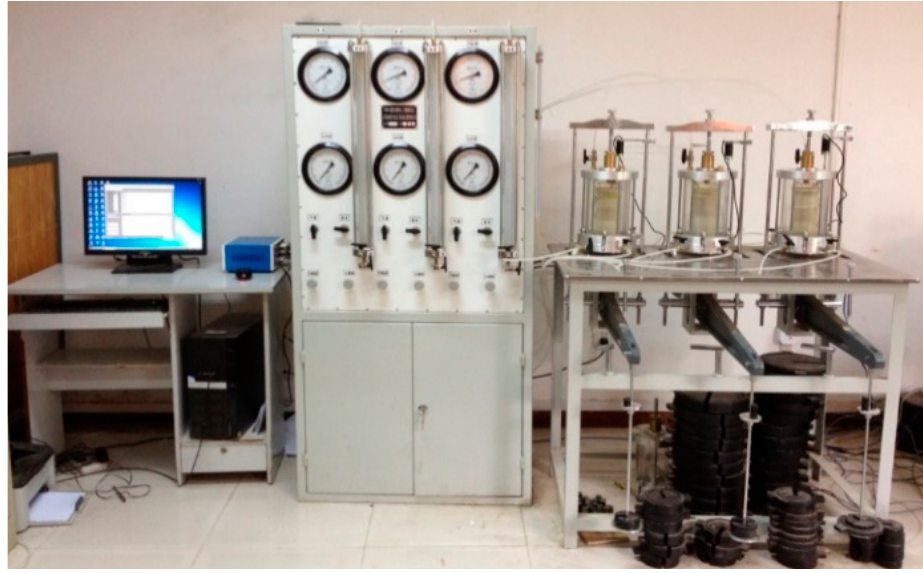
Figure 4. FSR-20 triaxial creep apparatus.